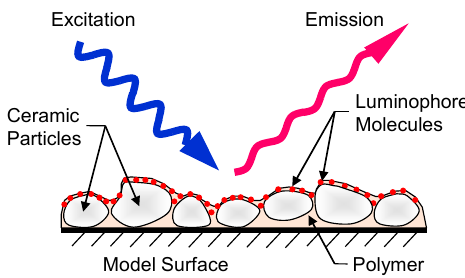
Figure 1. Schematic of basic pressure-sensitive paint (PSP) (adapted from Gregory et al. [3]).